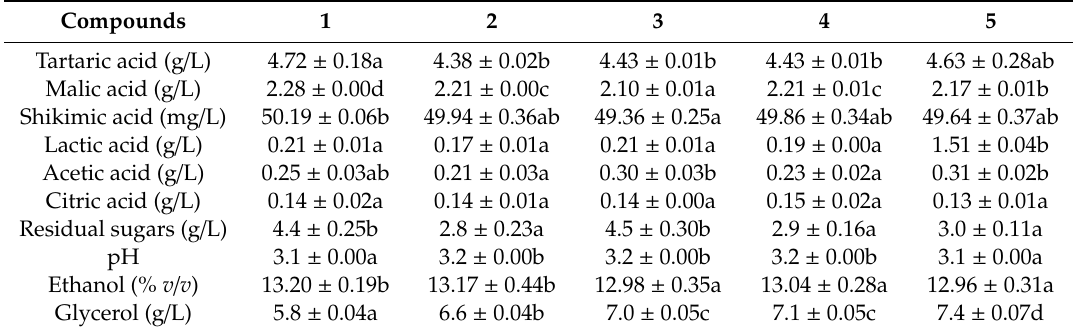
Table 1. Final analysis, before adding SO 2 , of S. cerevisiae Level 2 ® (1), and sequential fermentations with S. cerevisiae Level 2 ® and T. delbrueckii Level 2 ® (2), M. pulcherrima Flavia ® (3), P. kluyveri FrootZen ™ (4), and L. thermotolerans Concerto ™